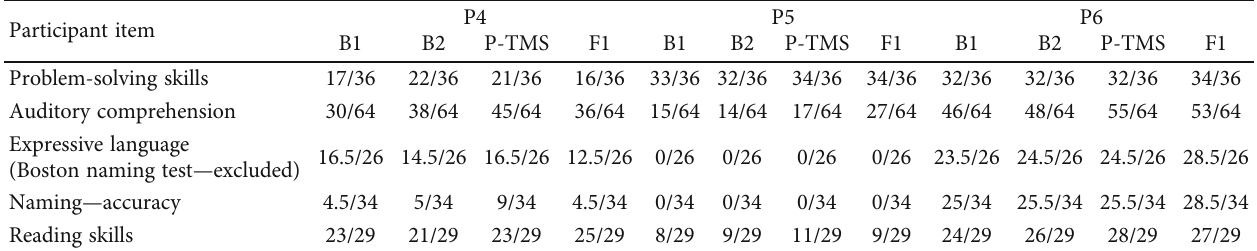
Table 3: Categorical language and cognitive scores at posttreatment and follow-up compared to baseline for P4, P5, and P6. Participant item Problem-solving